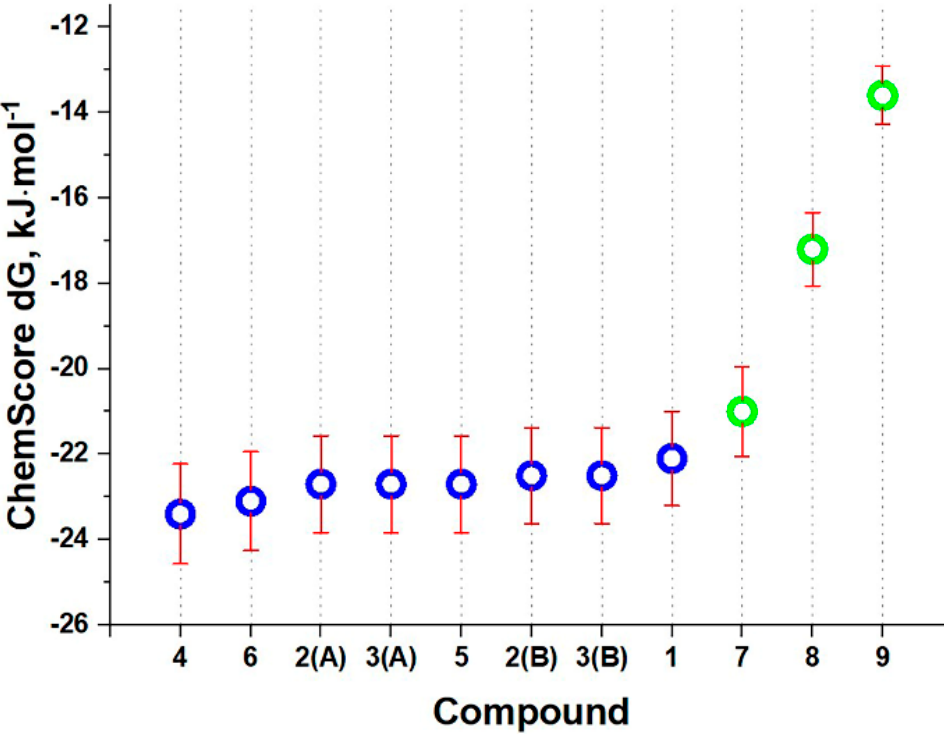
Figure 3. The ChemScore d G for «terpenoid–P2Y 12 » system ( 2(A) and 2(B) refers to 2 conformer A and conformer B respectively; 3(A) and 3(B) refers to 3 monomer A and monomer B, respectively (blue circle). The ChemScore d G for structurally related terpenoids presented in ref. [4] (green cir- cle).